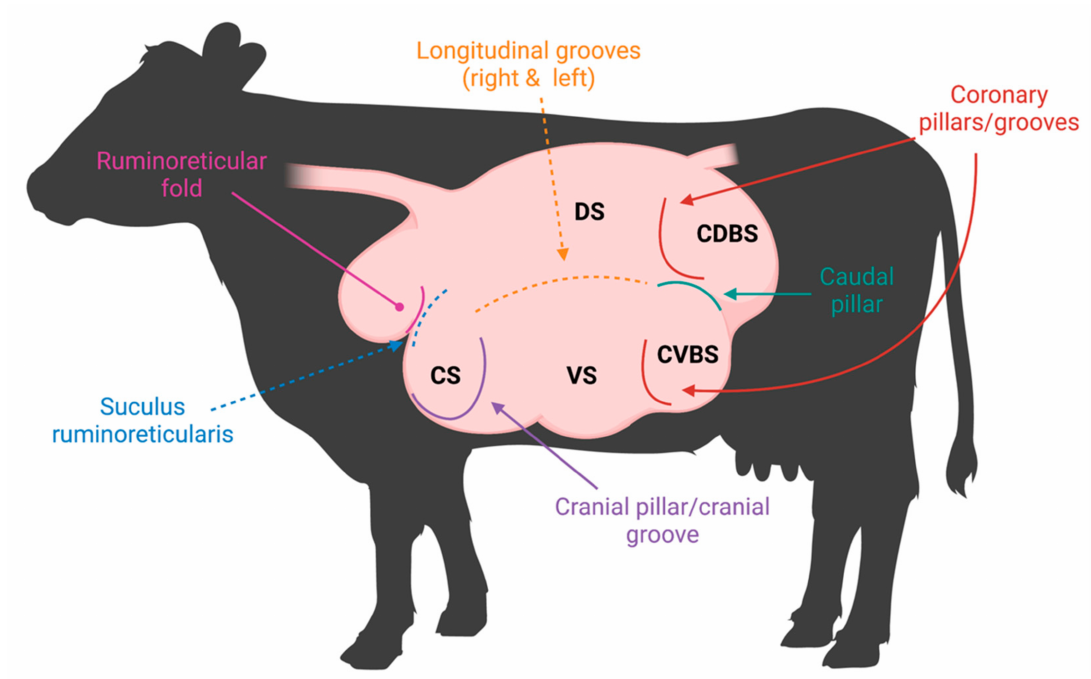
Figure 1. Rumen pillars and grooves visualized in a labeled rumen. Visual representation of musculature demarcating the rumen both internally (pillars) and externally (grooves). The rumen sacs are labeled as follows: cranial sac (CS), caudodorsal blind sac (CDBS), caudoventral blind sac (CVBS), dorsal sac (DS), and ventral sac